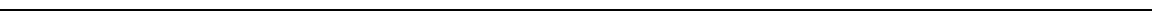
Fig. 4 Pax2 lineage-positive cells regenerate long tubule segments. a Representative image of a kidney section showing single-colored clones in S1 – S2 segments of proximal tubule as demonstrated by staining with anti-megalin antibody (white) in Pax2/Confetti mice at day 30 after IRI ( n = 5). Scale bar 20 µ m. b , c Representative images of a kidney section showing single-colored clones in S3 segment of proximal tubule as demonstrated by staining with anti-AQP1 antibody (white) in OSOM of Pax2/Confetti mice at day 30 after IRI ( n = 5). Scale bars 20 µ m. d Representative image of a kidney section showing single-colored clones in thick ascending limb as demonstrated by staining with anti-THP antibody (white) in Pax2/Confetti mice at day 30 after IRI ( n = 5). Scale bar 20 µ m. e Frequency of Pax2 + clones in S1 – S2 segment of proximal tubules (Pax2 + Megalin + clones, n = 5), in S3 segment of proximal tubules (Pax2 + AQP1 + clones, n = 7), in thick ascending limbs (TAL, Pax2 + THP + clones, n = 7) and in the collecting ducts (Pax2 + AQP2 + clones, n =